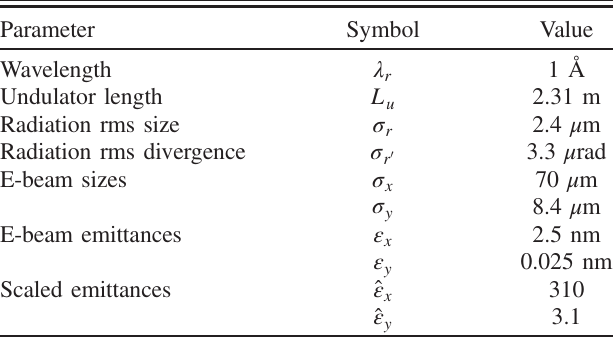
TABLE I. Nominal source and e-beam parameters for undu- lator A at the Advanced Photon Source.